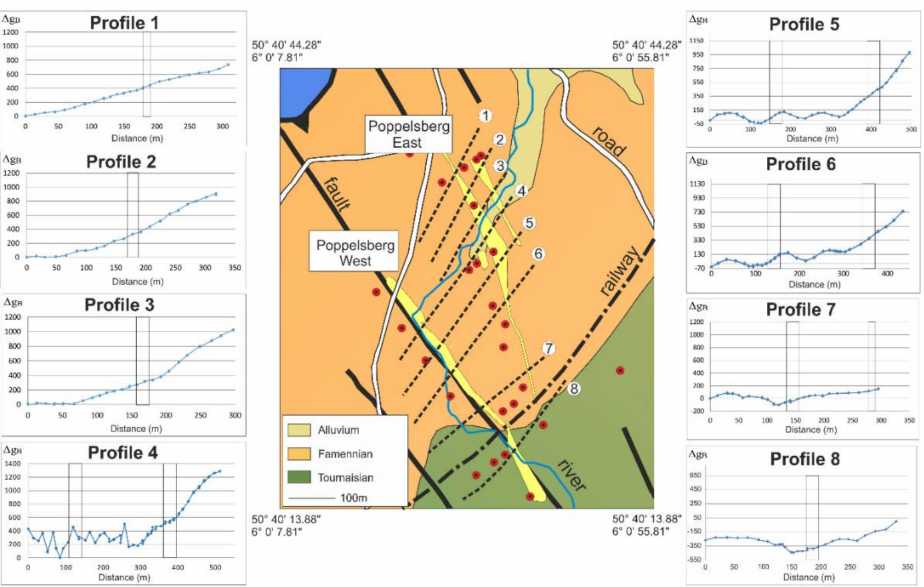
Figure 9. Bouguer gravity anomaly after processing of the dataset (geological map modified from Laloux et al. [30]). Units are µ Gal. The rectangles present on the profiles correspond to the supposed location of the Pb–Zn vein according to the 3D modelling.